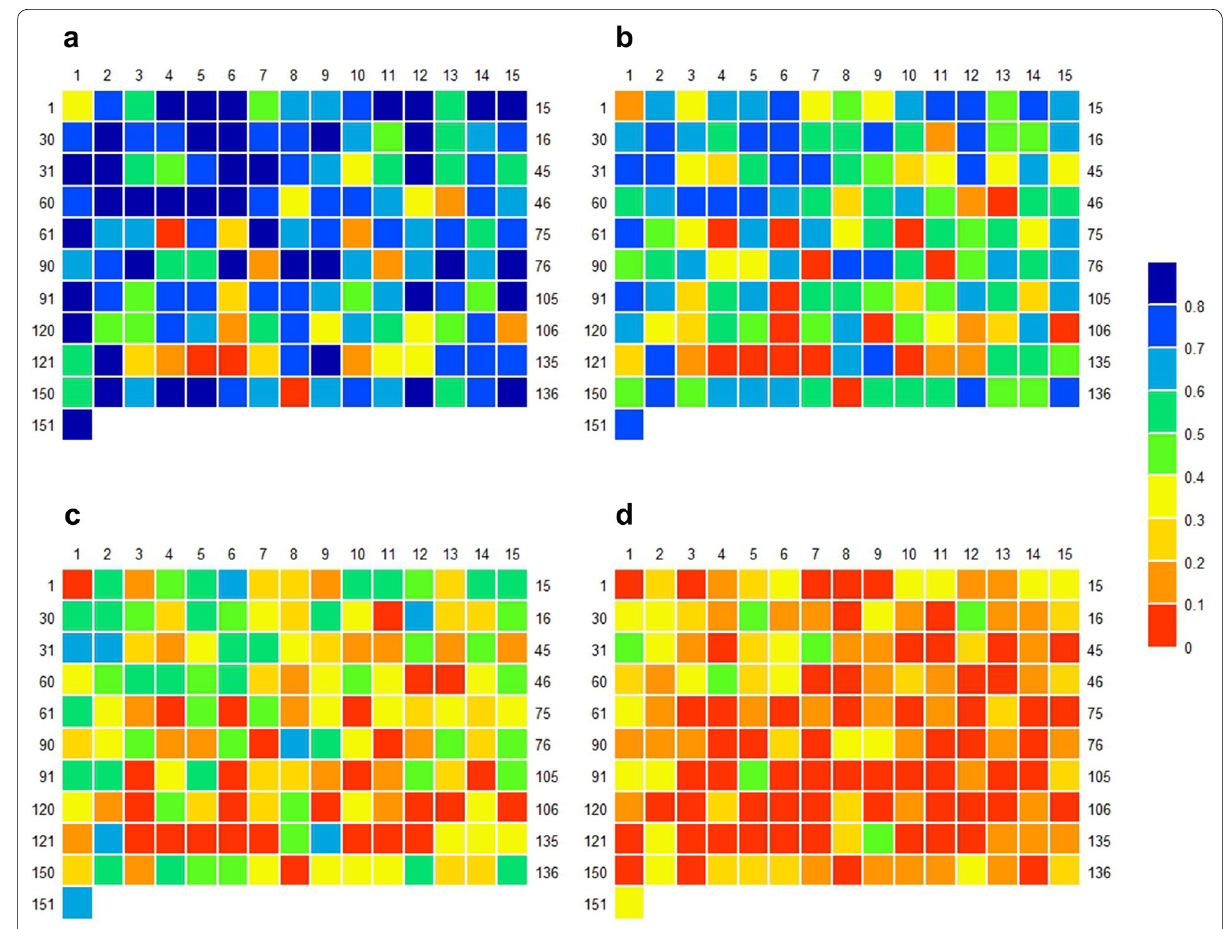
Fig. 5 Degree centrality values for the annual streamflow network from the Mississippi River basin for four different thresholds ( T ): a T T 0.5; c T 0.6; and d T 0.7. Each box represents a node = = =